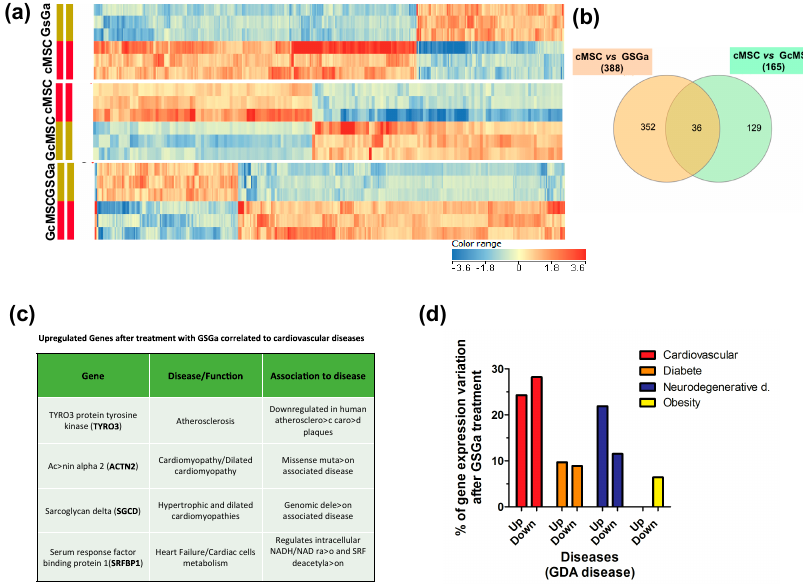
Figure 9. Transcriptional profiling of cMSC following GSGa treatment. ( a ) Heat-maps show significantly upregulated and downregulated genes in cMSC following prolonged (GcMSC/cMSC) or 3-day (GSGa/cMSC) GSGa treatment and those in GSGa with respect to GcMSCS (GcMSC/GSGa). Heat-maps were generated by hierarchical clustering of genes accordingly to the fold change. Cut-off p value ≤ 0.05; Cut o ff fold change 1.5. ( b ) Venn diagram depicts overlap of di ff erentially regulated genes after 3 days (GSGa) and 30 days (GcMSC) of treatment. The diagram has been generated by using InteractiVenn webtool (http: // www.interactivenn.net) inputting the probe name lists from the gene array data. ( c ) Selection of significantly upregulated genes following GSGa treatment whose function was associated with cardiovascular diseases. ( d ) Histograms show gene expression variation (upregulation: up; downregulation: down) after GSGa treatment (GSGa) of genes associated with the diseases indicated in the